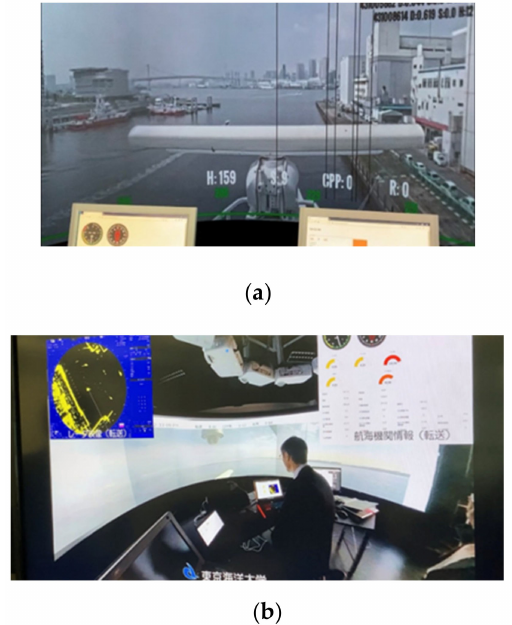
Figure 3. ( a ) Screen at RCC (scenery from berthed training ship); ( b ) RCC at the demonstration